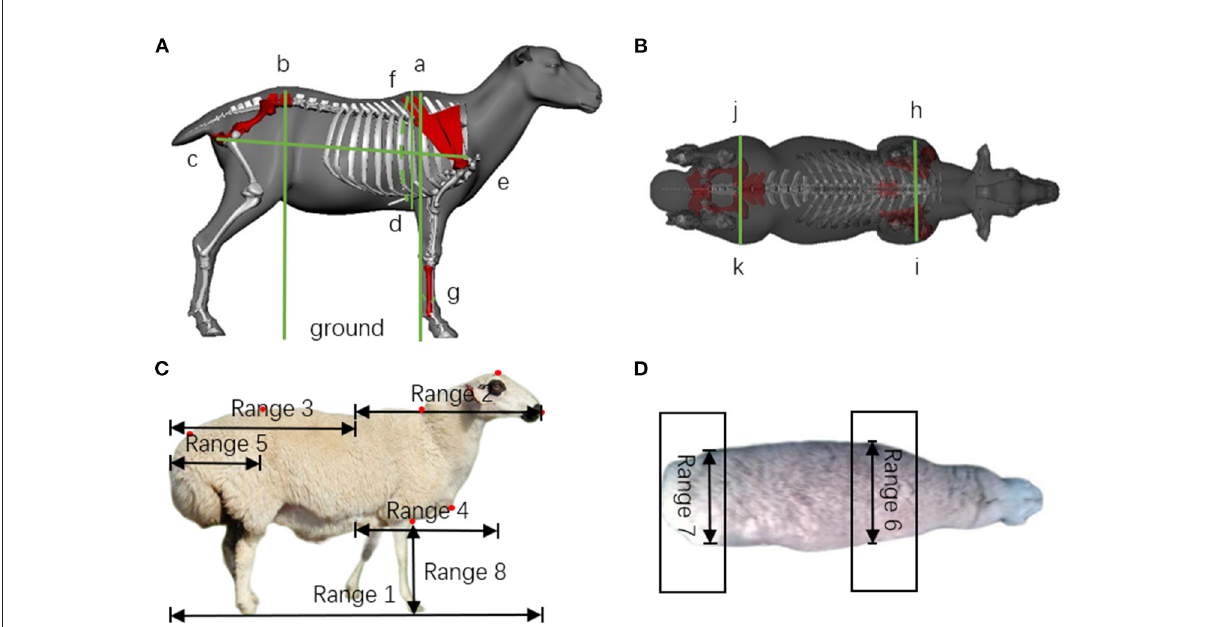
FIGURE2 Artificial measurement feature point location diagram and machine visual feature point pickup range. (A,B) Show the location of body-scale data measurements on the sheep, HW: a-ground, BSL: c-e, CD: a-d, CC: f-f, SC: g-g, HH: b-ground, SW: h-i, RW: j-k. (C,D) Show the range of lateral and dorsal body-scale points measured on the